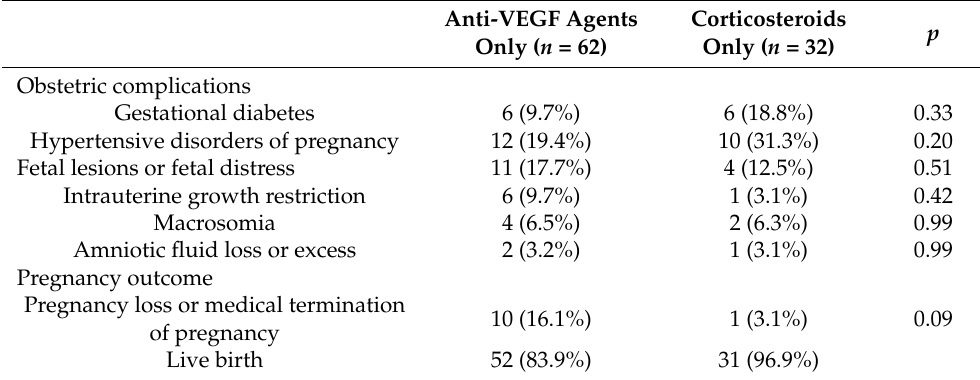
Table 4. Comparison of obstetric complications and pregnancy outcomes between women who had anti-VEGF agents only vs. corticosteroid IVTs only during pregnancy or in the month preceding pregnancy, between 2013 and 2018 ( n = 94).